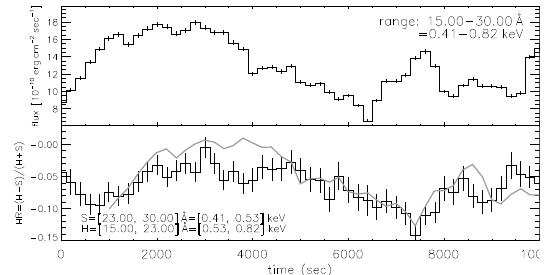
Figure 1: Reproduction of figure 8 from (Ness et al. 2007). The Chandra light curve on day 39.7, taken during the early high-amplitude variability phase, was also highly variable on shorter time scales. The hard- ness ratio, shown in the bottom, evolved with the same variability patterns but lagged 1000 seconds behind the brightness variations. Reproduced by permission of the AAS.